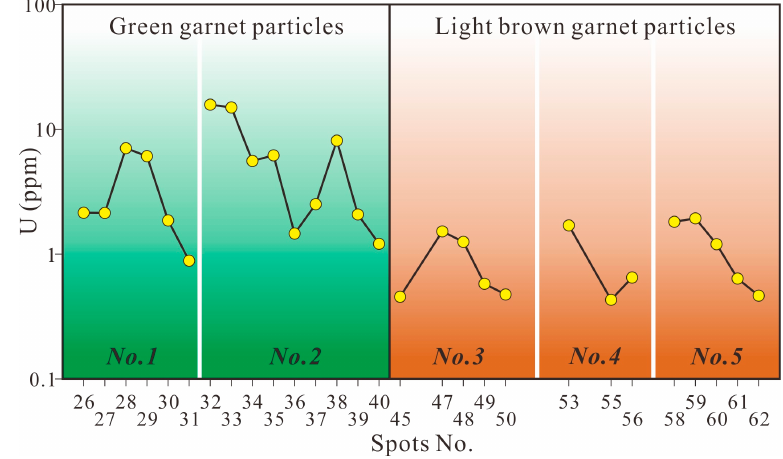
Figure 13. Line chart of the U concentrations from cores to rims in the green and light brown garnet grains; the U concentrations from core to rim in all these grains are irregular.